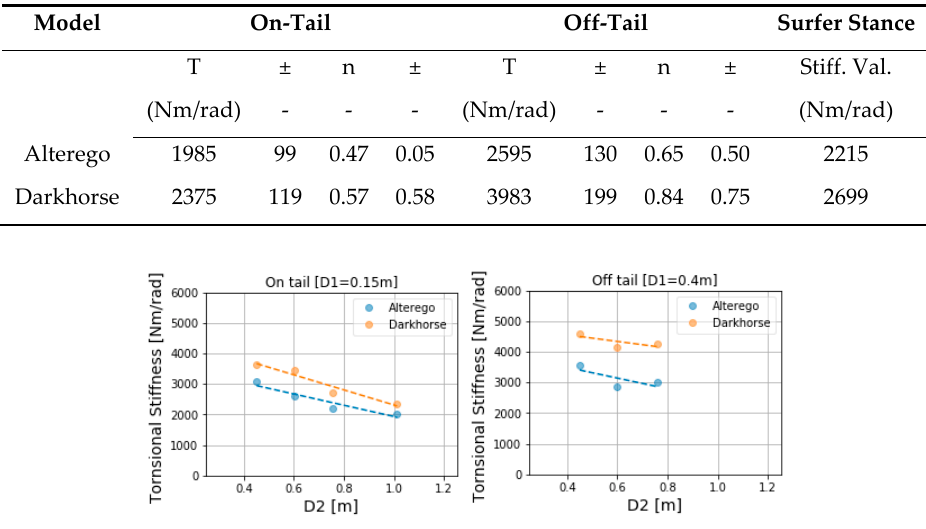
Figure 3. Torsional stiffness of the board for varying D2. ( Left ) On-tail configuration. ( Right ) Off-tail configuration. Dashed lines are power-law fits to the data.